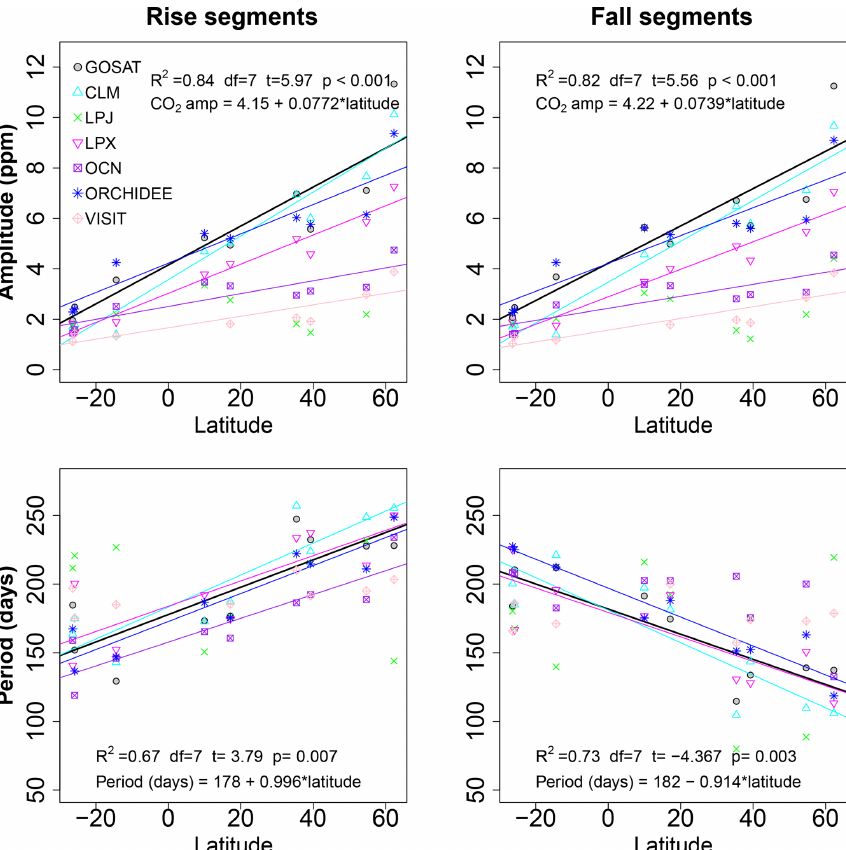
Figure 4. Latitudinal variation in amplitude and period in rise and fall segments among TransCom regions, using the average latitude for each region. Linear regressions are shown when significant ( p < 0 . 05). Regression statistics and equation are only given for